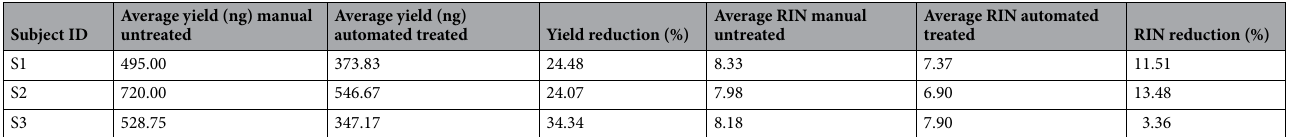
Table 3. RNA yield and RIN reduction induced by TURBO DNA Free treatment in the automated protocol (50 μl